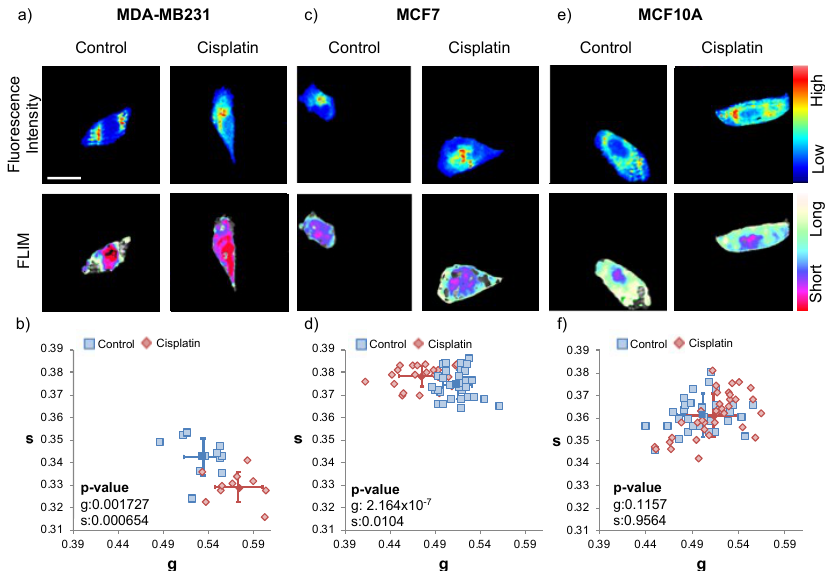
Figure 2. Fluorescence lifetime trajectories of the metabolic state of MDA-MB-231, MCF7, and MCF10A cells with 20 µ M cisplatin treatment for four hours. ( a ) Fluorescence intensity image (top), and FLIM image pseudo colored long lifetime as cyan and short lifetime as red (bottom) for control and cisplatin-treated MDA-MB-231 cells; the scale bar is 20 µ m, and all the images in this figure have the same scale. ( b ) The g and s values of control and cisplatin-treated MDA-MB-231. The blue squares are from the controls (untreated MDA-MB-231), red diamonds are from the cisplatin-treated MDA-MB-231, and the solid shapes (square and diamond) with the error bars correspond to the average and the standard deviation of each group (using the Student t-test to compare the treated group to the control group, p -values for g, s and free to bound NADH ratio are 0.001727, 0.000654, 0.000154, representatively). FLIM plot illustrates a rightward shift from long to short lifetimes. ( c ) Fluorescence intensity image (top), and FLIM image pseudo colored long lifetime as cyan and short lifetime as red (bottom) for control and cisplatin-treated MCF7 cells. ( d ) The g and s values of control and cisplatin-treated MCF7. The blue squares are from the controls (untreated MCF7), red diamonds are from the cisplatin-treated MCF7, and the solid shapes (square and diamond) with the error bars correspond to the average and the standard deviation of each group (using the Student t-test to compare the treated group to the control group, p -values for g, s and free to bound NADH ratio are 2.164 × 10 − 7 , 0.0104, 2.34 × 10 − 7 , respectively). The FLIM plot indicates a leftward shift from short to long lifetimes. ( e ) Fluorescence intensity image (top), and FLIM image pseudo colored long lifetime as cyan, and short lifetime as red (bottom) for control and cisplatin-treated MCF10A cells. ( f ) The g and s values of control and cisplatin-treated MCF10A. The blue squares are from the controls (untreated MCF10A), red diamonds are from the cisplatin-treated MCF10A, and the solid shapes (square and diamond) with the error bars correspond to the average and the standard deviation of each group (Student t-test p -value: g = 0.1157, s = 0.9564, free to bound NADH ratio = 0.0643). FLIM plot illustrates there is no significant shift. This experiment has been scientifically repeated three times. The two other repeats are in Figure